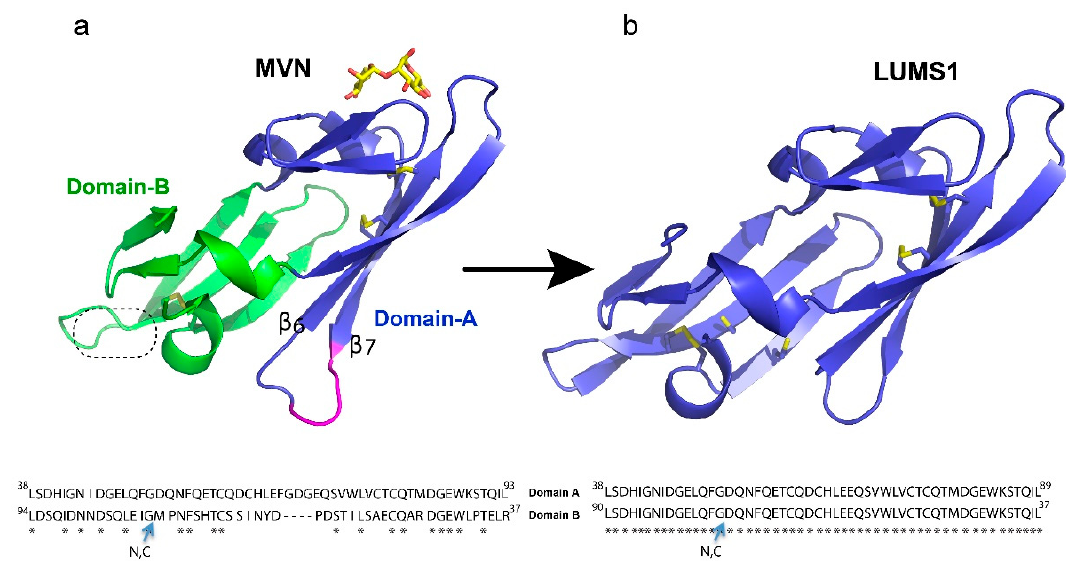
Figure 1. Description of the protein design: ( a ) microvirin (MVN) structure (PDB ID 2YHH) shown in cartoon presentation with two structural domains colored blue and green while bound glycan is colored yellow. Insertion of four amino acids in domain-A as compared to domain-B is indicated in magenta. The second putative carbohydrate binding site is indicated by a dotted circle. ( b ) The homology-modeled structure of LUMS1 was created through SWISS-MODEL online tools using MVN as a template. Qualitative model energy analysis (QMEAN) scoring function was used to access the quality of the model. Side chains of all cysteine residues in both proteins are shown in gold sticks. Alignment of amino acid sequence of two domains of MVN and LUMS1 is shown at the bottom of the respective protein structure. N, C indicates N- and C-termini of the protein sequences.